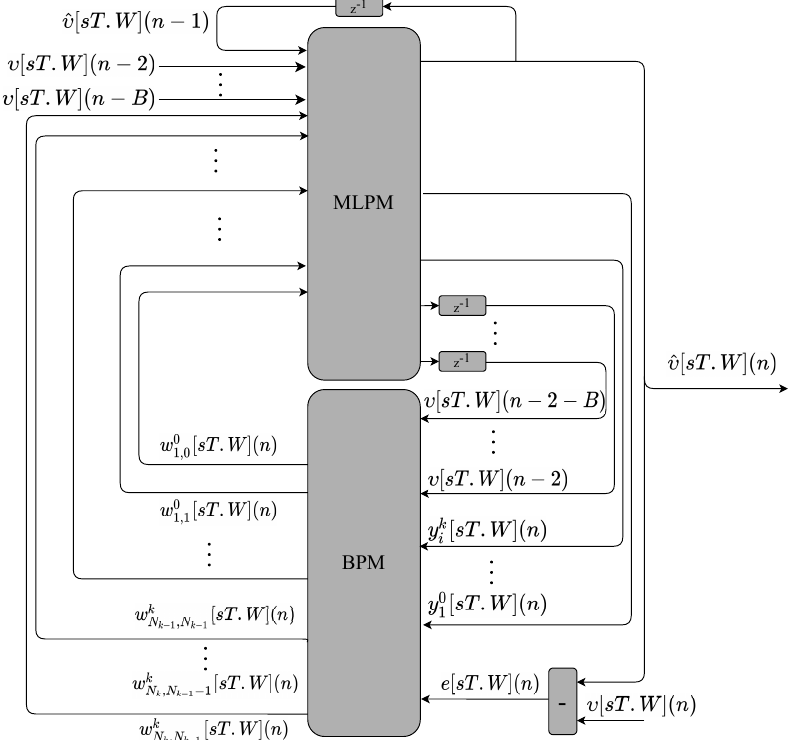
Figure 11. Main hardware modules implemented to perform the